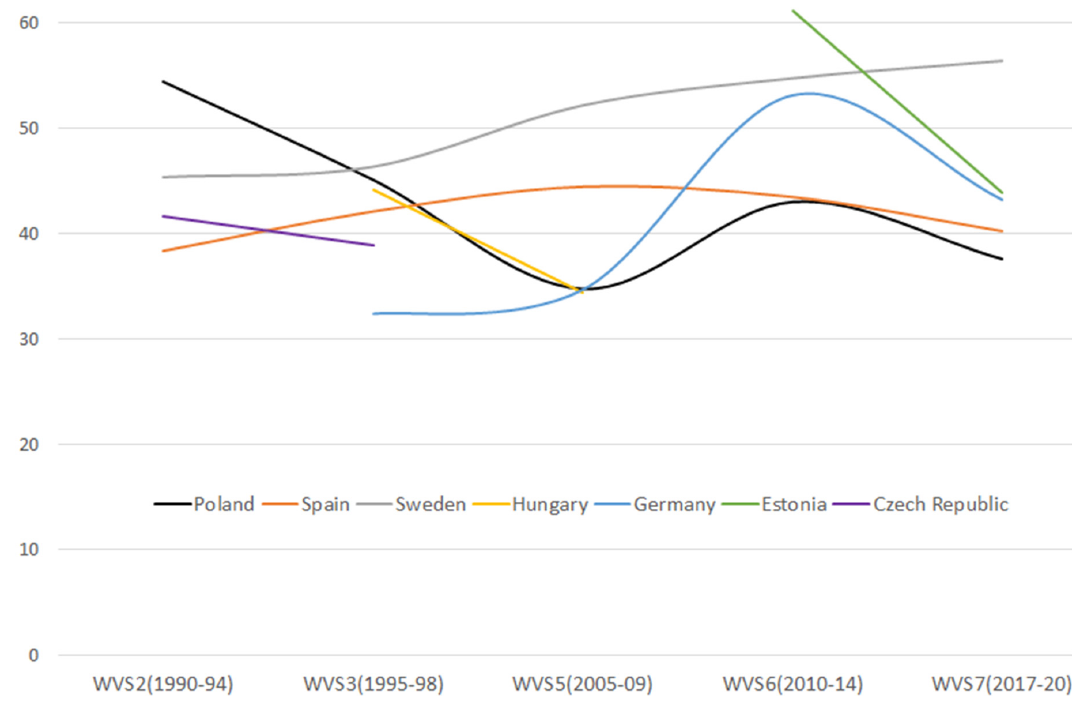
Figure 19. Liberal democracy index. Source: VDEM [51].